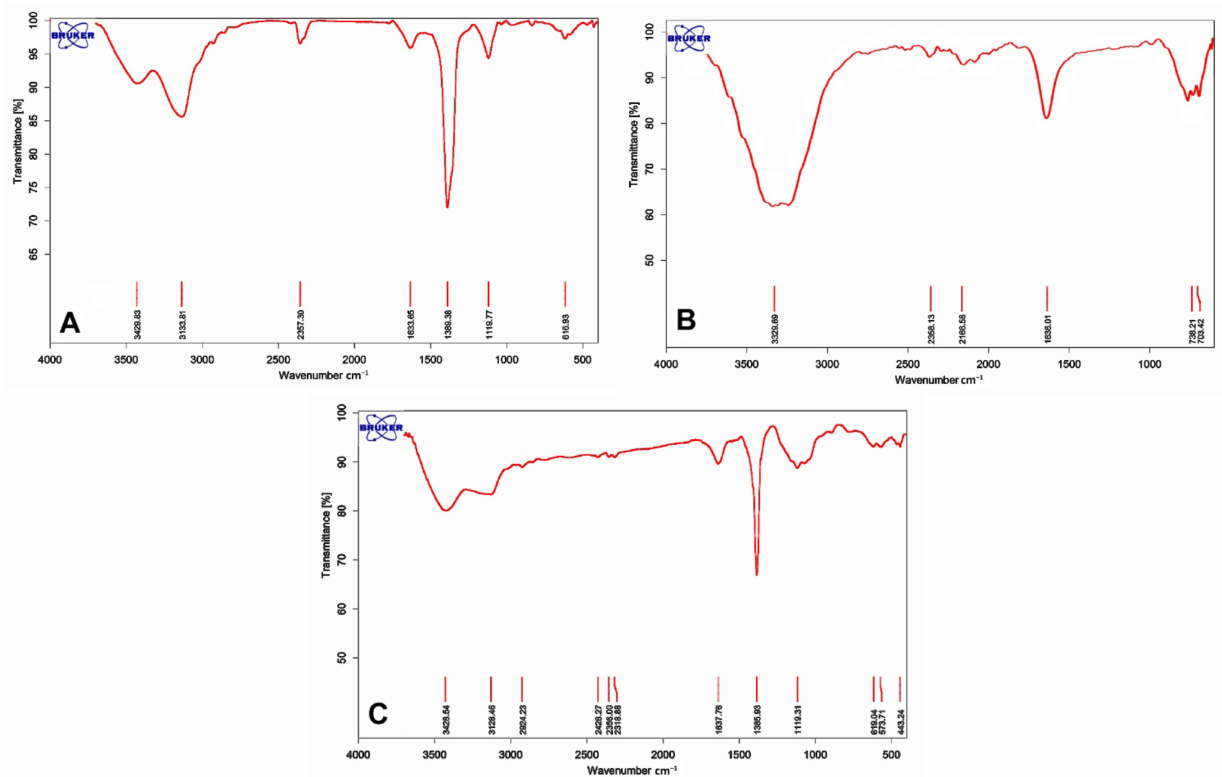
Figure 3. FTIR of ( A ) Fe-Ni@rGO, ( B ) AuNUs, and ( C )